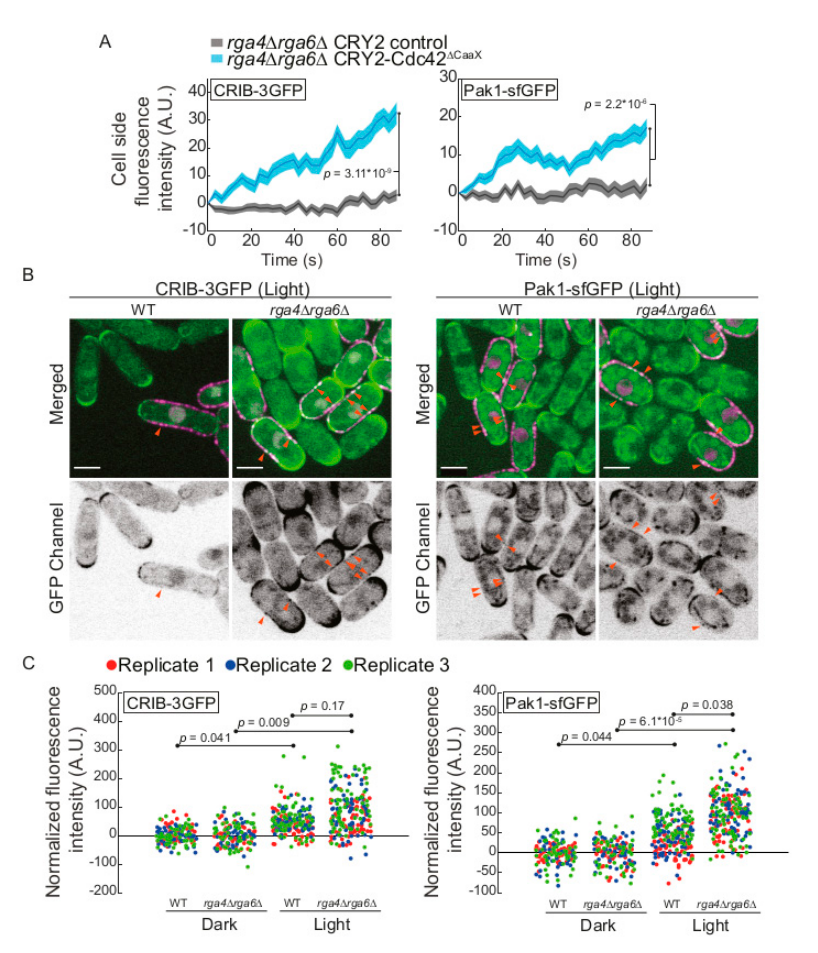
Figure 5. Stronger CRY2-Cdc42 ∆ CaaX activation in cells lacking lateral Cdc42 GAPs. ( A ) Quantification of CRIB-3GFP and Pak1-sfGFP signal intensity at cell sides of rga4 ∆ rga6 ∆ mutants, n > 80 cells. Exact numbers are listed in the methods. ( B ) Localization of CRIB-3GFP and Pak1-sfGFP in control and CRY2-Cdc42 ∆ CaaX -expressing cells upon 30 min-exposure to light (B / W inverted images and green channel in merge). Merged images are composites of GFP and RFP single middle-section images. Arrowheads point to lateral CRIB-3GFP and Pak1-sfGFP signal. Control cells lack the CRY2-Cdc42 ∆ CaaX magenta signal in the merged images. ( C ) Cluster plots of CRIB-3GFP and Pak1-sfGFP signal intensity at cell sides of WT and rga4 ∆ rga6 ∆ mutants, n > 138 cells. Exact numbers are listed in the methods. The three experimental replicates are plotted with di ff erent colours. Statistical p -values are from t-test across experimental replicates ( n = 3). In all graphs, thick line = average; shaded area = standard error of the mean (SEM); WT, wild type; A.U., arbitrary units. Bars = 4 µm. Associated trace analysis is shown in Figure S8. Autofluorescent organelles appear as linear and circular structures in some of the GFP channel images.